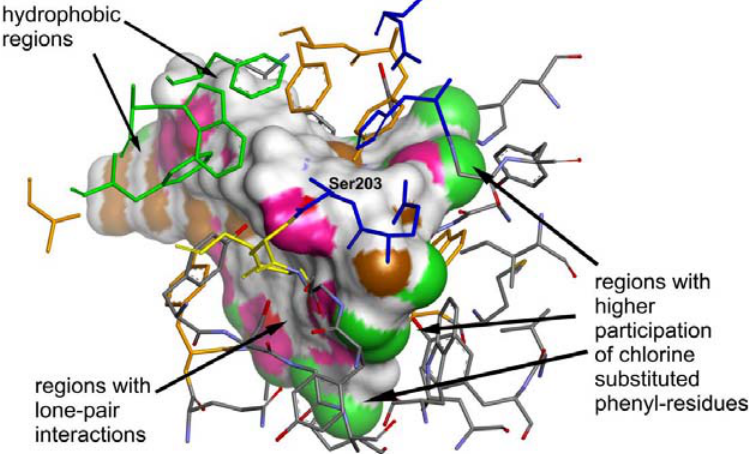
Figure 5. Three-dimensional view from within active site gorge (using same colour scheme for active site as in Figure 4A), containing the overlaid highest-ranked conformations of all docked ligands, represented by solvent accessible surface coloured by element appearance (chlorine-green, carbon and hydrogen-brown or white) or lone pair presence (purple colour), showing regions with preferred orientation of different residues (especially hydrophobic region near ABS site, regions containing high occurrence of lone- pair interactions near OAH and PAS, and regions with higher occurrence of chlorine- substituted phenyl residues near catalytic